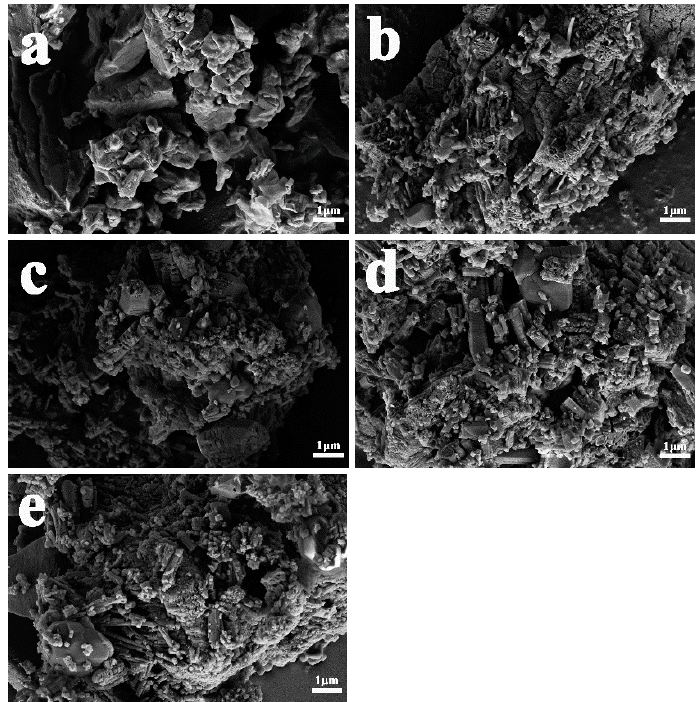
Figure 3. SEM images of ( a ) tri-g-C 3 N 4 , ( b ) 1CoO x /tri-g-C 3 N 4 , ( c ) 3CoO x /tri-g-C 3 N 4 , ( d ) 5CoO x /tri-g-C 3 N 4 , and ( e ) 7CoO x /tri-g-C 3 N 4 .